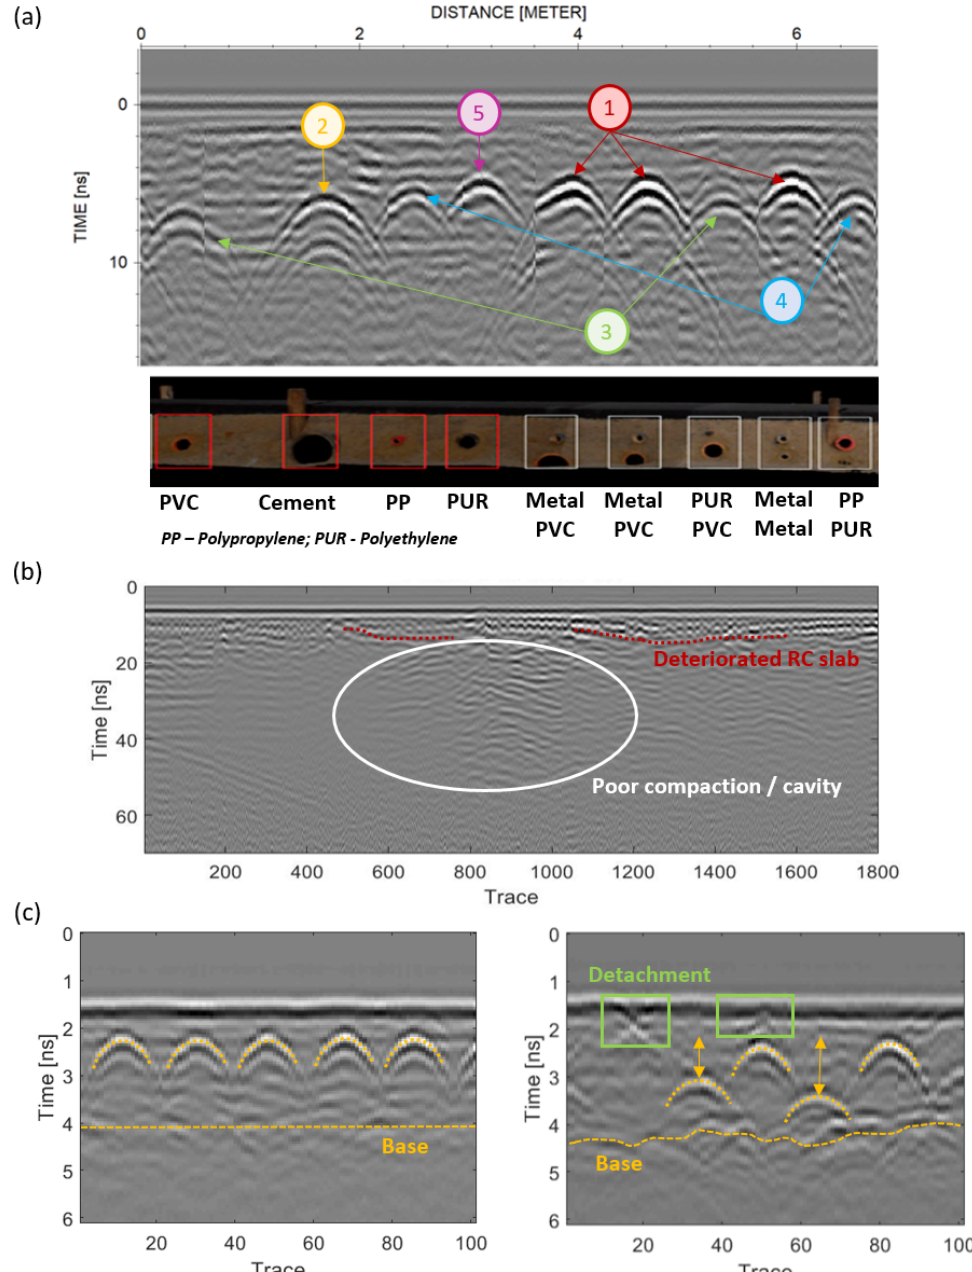
Figure 1. Examples of GPR application in civil engineering: 1 GHz data to detect underground pipes (metal (1), cement (2), PVC (3), polypropylene (4), and polyethylene (5)) ( a ), 500 MHz data in a rigid pavement ( b ), and 2.3 GHz data in building RC slab ( c ). Adapted with permission from Refs. [18,70]. Author’s own work and Copyright 2017, Elsevier.